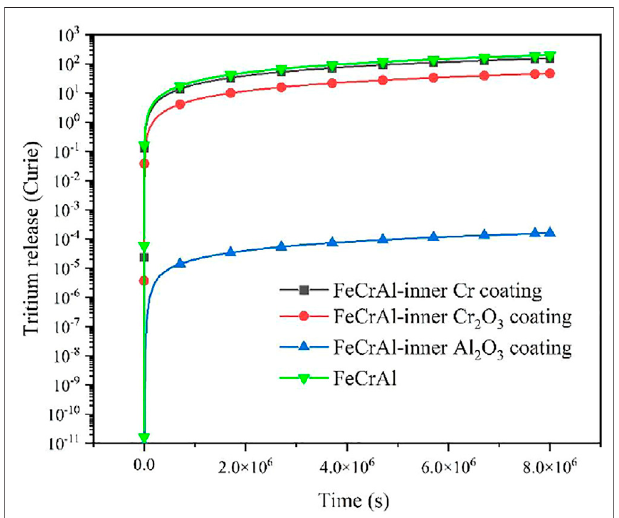
FIGURE 19 | Total tritium release when the coating is on the outer surface of the